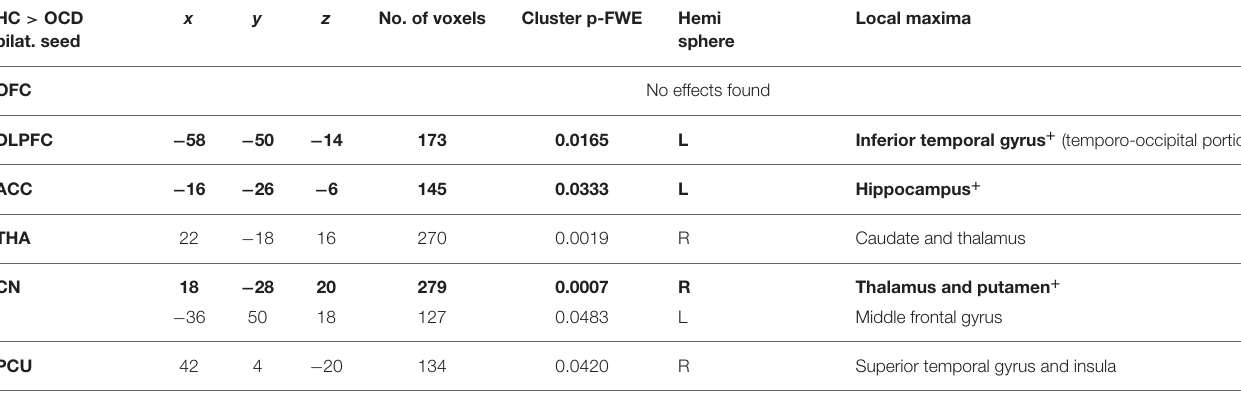
TABLE 4 | Decreased connectivity in the OCD patients compared to HC in the selected ROIs. x y HC > OCD bilat. seed